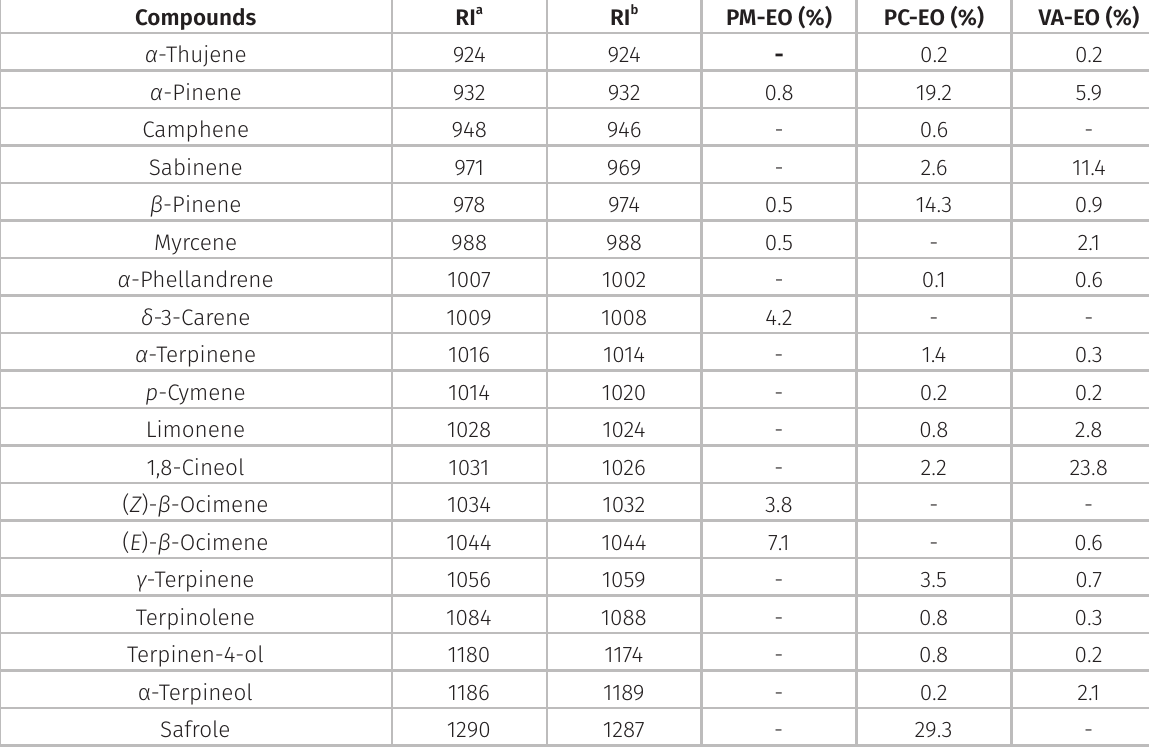
Table I. Chemical constituents of the essential oil of P. marginatum , P. callosum and V. agnus-castus . Compounds RI